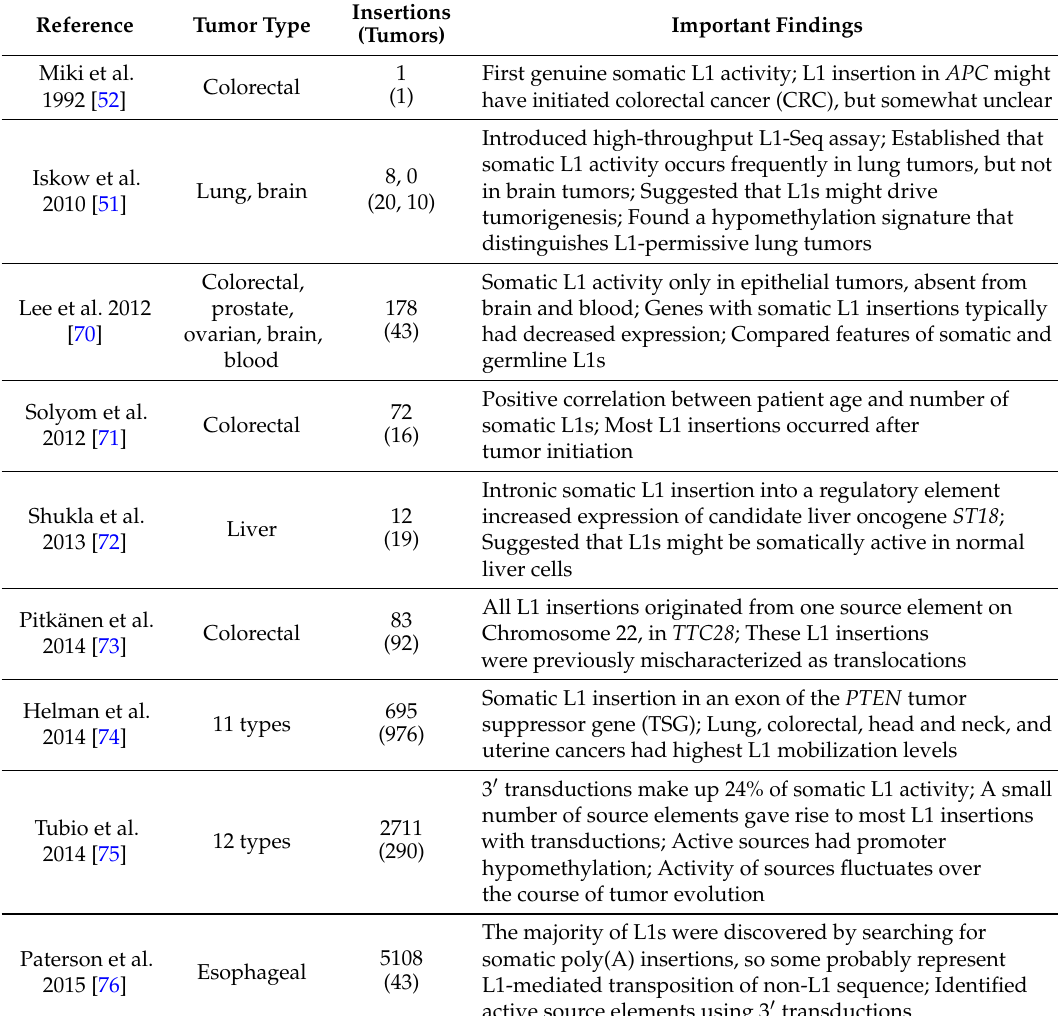
Table 1. Studies of somatic L1 activity in cancer genomes. Column three gives the total number of somatic L1 insertions discovered in the total number of tumors assayed; these estimates take validation rates into account when